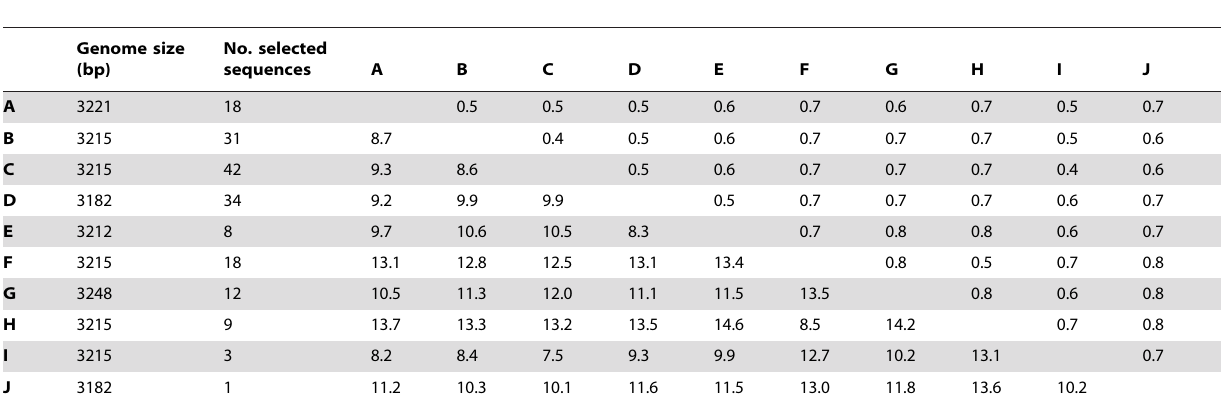
Table 1. The genome size, number and mean percentage of nucleotide sequence divergence between HBV genome from genotype A to J analyzed in this study.